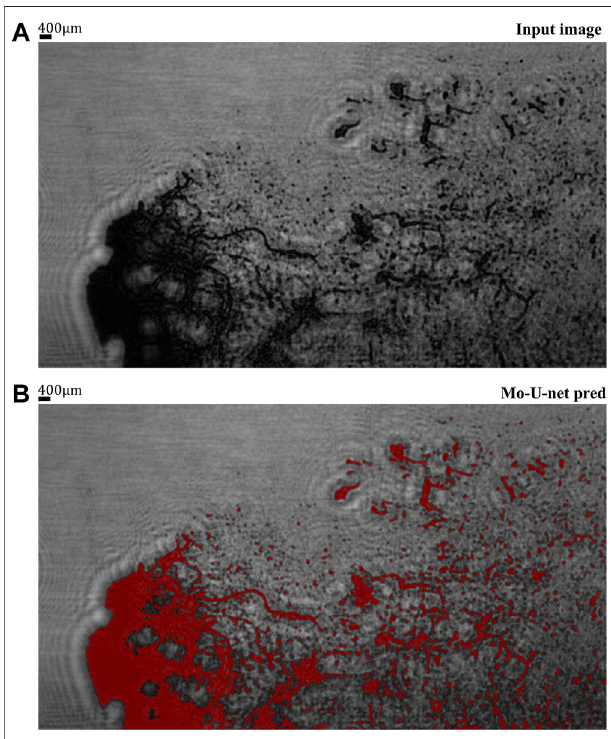
FIGURE 7 | The overview of Mo-U-net predicting performance. Subgraph (A) shows the input image of fi lament-droplet fi eld in case 5. Subgraph (B) isthesuperpositionoftheMo-U-netpredictionandinputimage, in which the predicted pixels are painted red.